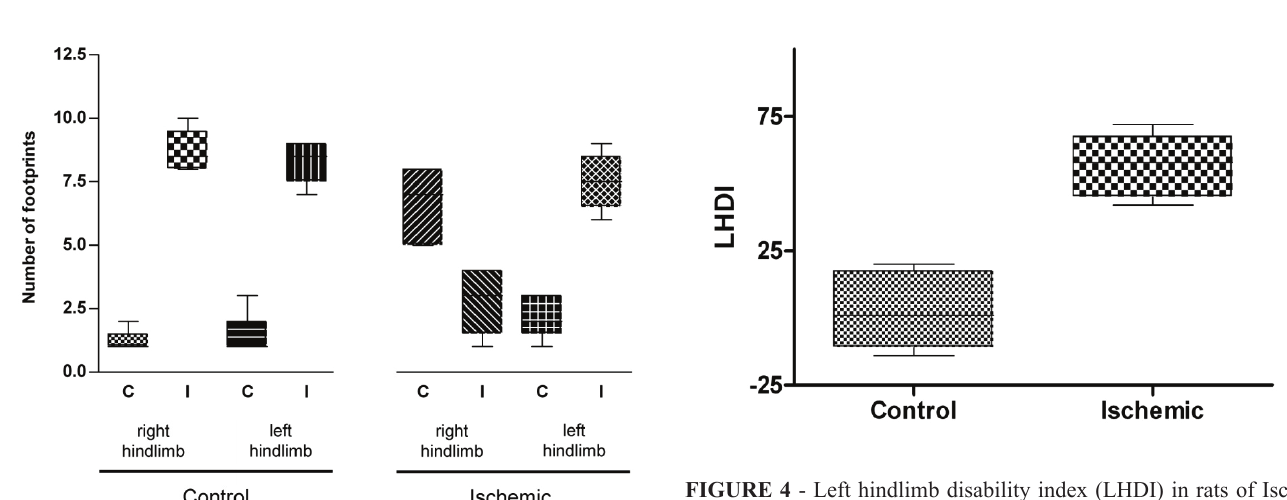
FIGURE 4 - Left hindlimb disability index (LHDI) in rats of Ischemia and Control groups. (—) mean; (□) confidence interval; (‡) standard